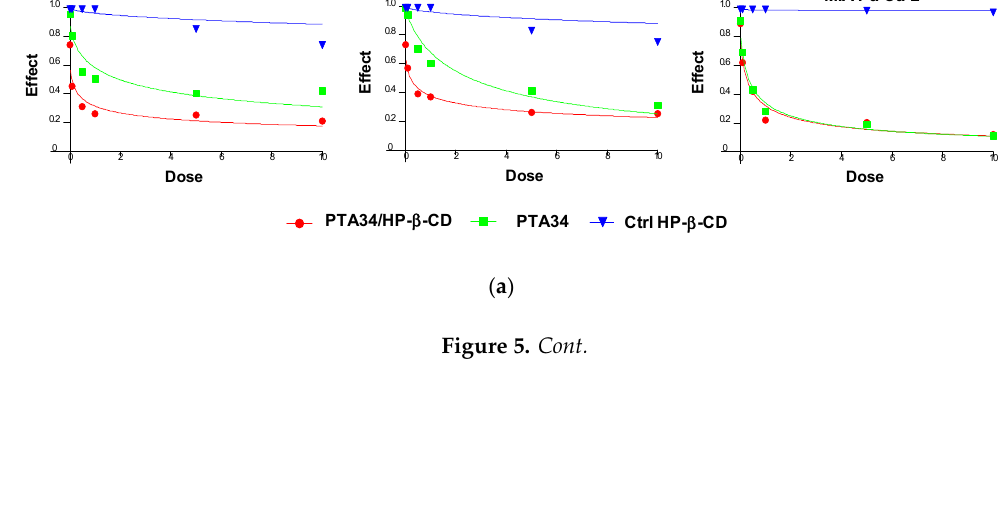
Table 2. Inhibitory Effect of PTA Compounds and PTA/HP- β -CD Complexes on Pancreatic Ductal Adenocarcinoma (PDAC) Cancer Cells.